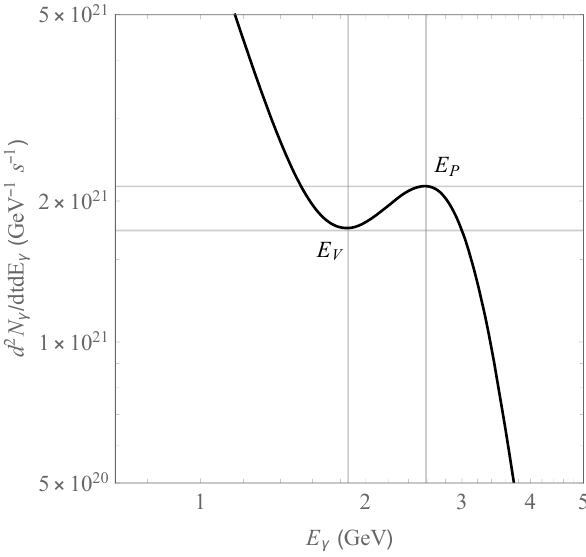
Figure 2 . Photon spectrum near the primary emission peak for M = 2 . 5 × 10 10 kg and ˜ a = 0 . 3 , illustrating the quantities characterizing the “valley-peak”